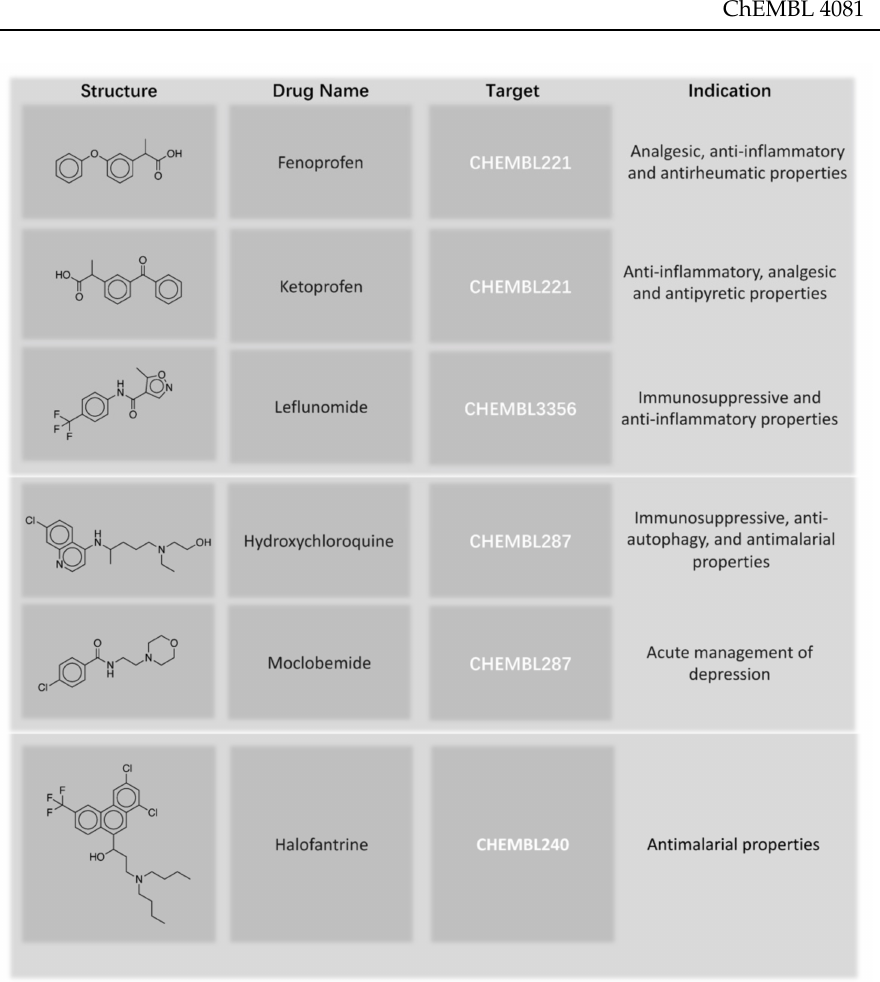
Figure 8. Structures of the approved drugs that the fine-tuned model predicted all the right targets for. The drug names and indication information are from